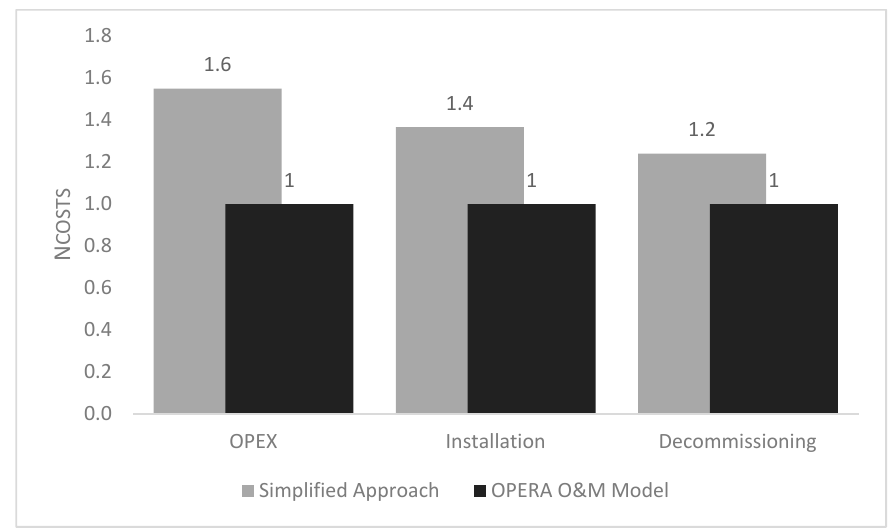
Figure 9. Normalised OPEX, installation and decommissioning costs calculated using the OPERA O&M